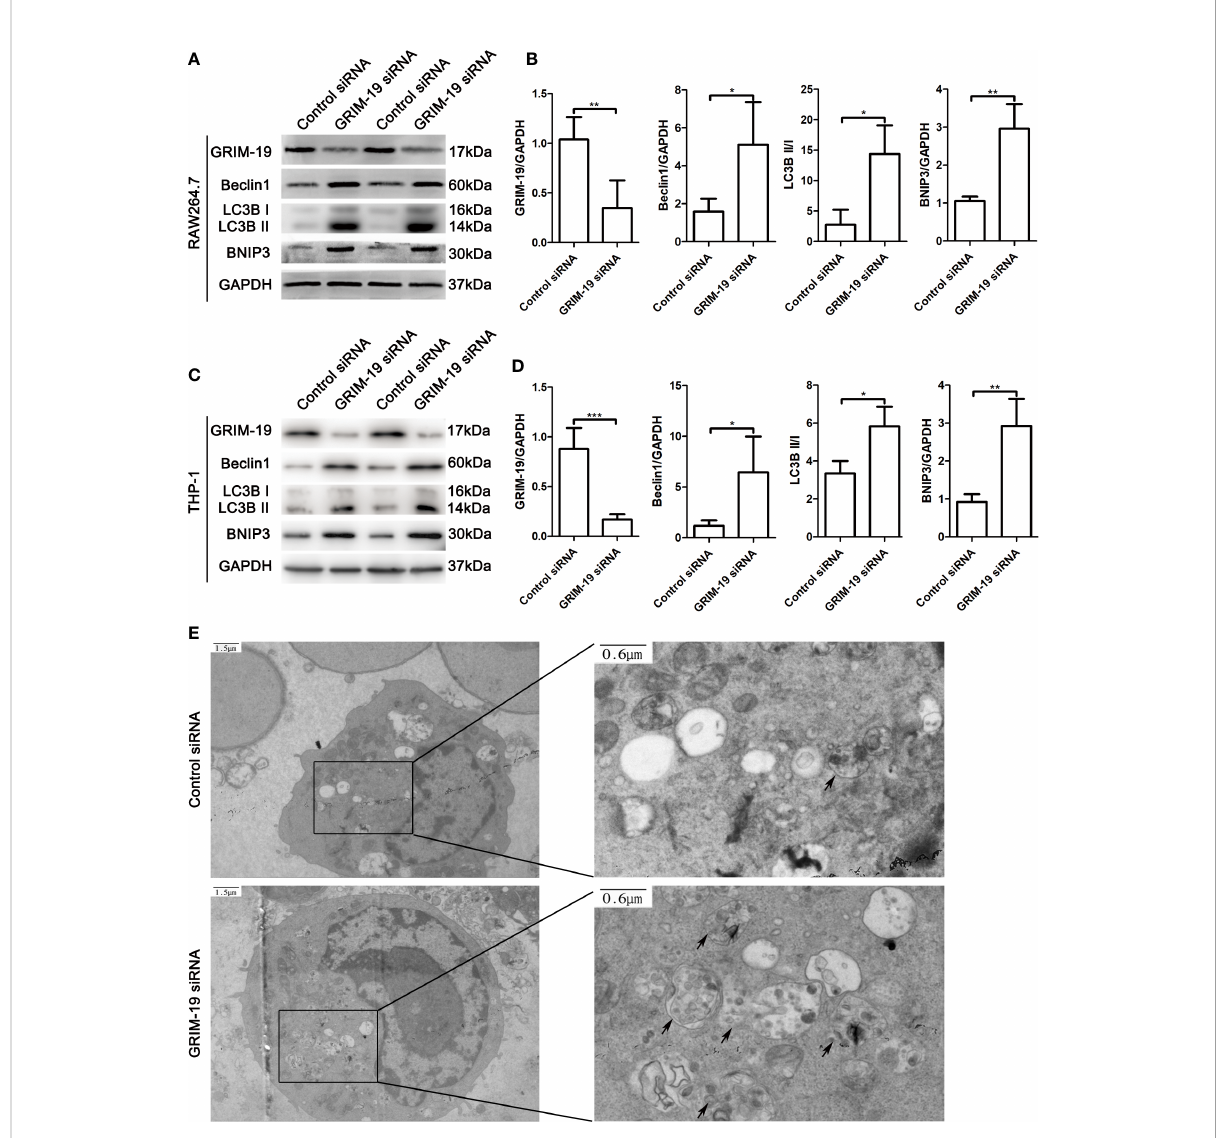
FIGURE 3 Downregulation of GRIM-19 stimulates autophagy in murine macrophage RAW264.7 cells and THP-1-derived macrophages. (A) Representative western blotting images of GRIM-19, Beclin1, LC3B II/I and BNIP3 in RAW264.7 cells after downregulation of GRIM-19. GAPDH served as a loading control. (B) Quanti fi cation of GRIM-19, Beclin1, LC3B II/I and BNIP3 expression through relative densities. Data are shown as the mean ± SD. Three independent experiments were carried out. (C) Representative western blotting images of Grim-19, Beclin1, LC3B II/I and BNIP3 in THP-1 cells after downregulation of Grim-19. GAPDH served as a loading control. (D) Quanti fi cation of Grim-19, Beclin1, LC3B II/I and BNIP3 expression through relative densities. Data are shown as the mean ± SD. Three independent experiments were carried out. *** p < 0.001, ** p < 0.01, * p < 0.05. (E) Autophagosomes were observed by